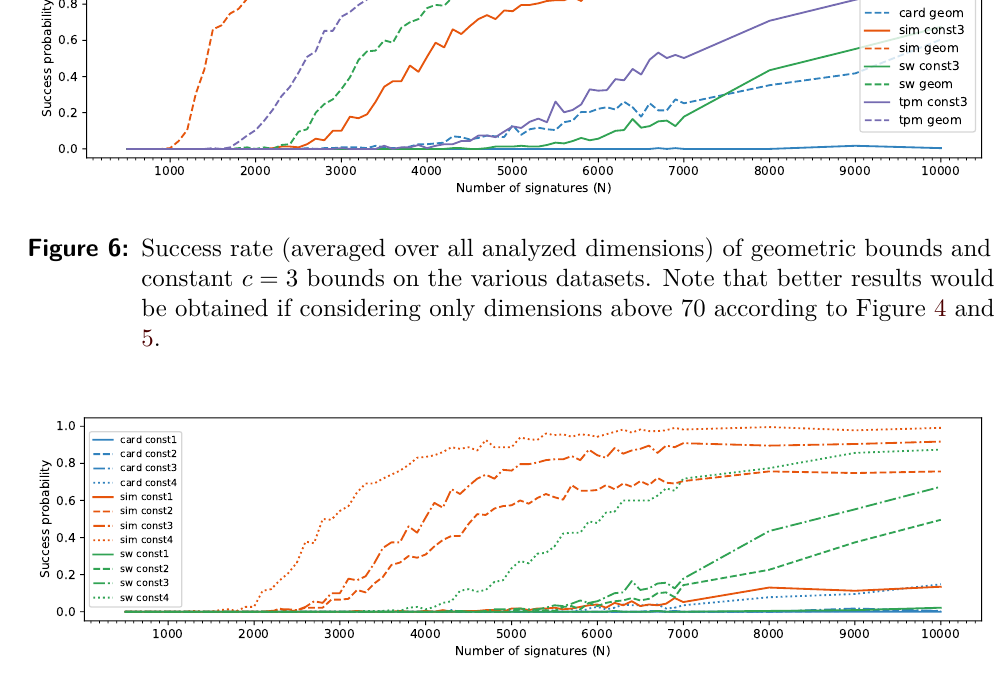
Figure 7: Success rate (averaged over all analyzed dimensions) of constant bounds with c ∈ { 1 , 2 , 3 , 4 } on the various